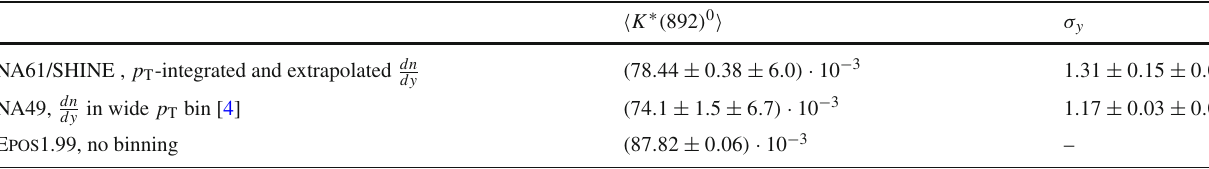
Table 6 The mean multiplicities (cid:5) K ∗ ( 892 ) 0 (cid:6) and the widths of the rapidity distributions σ y obtained from dn The first uncertainty is statistical and the second systematic